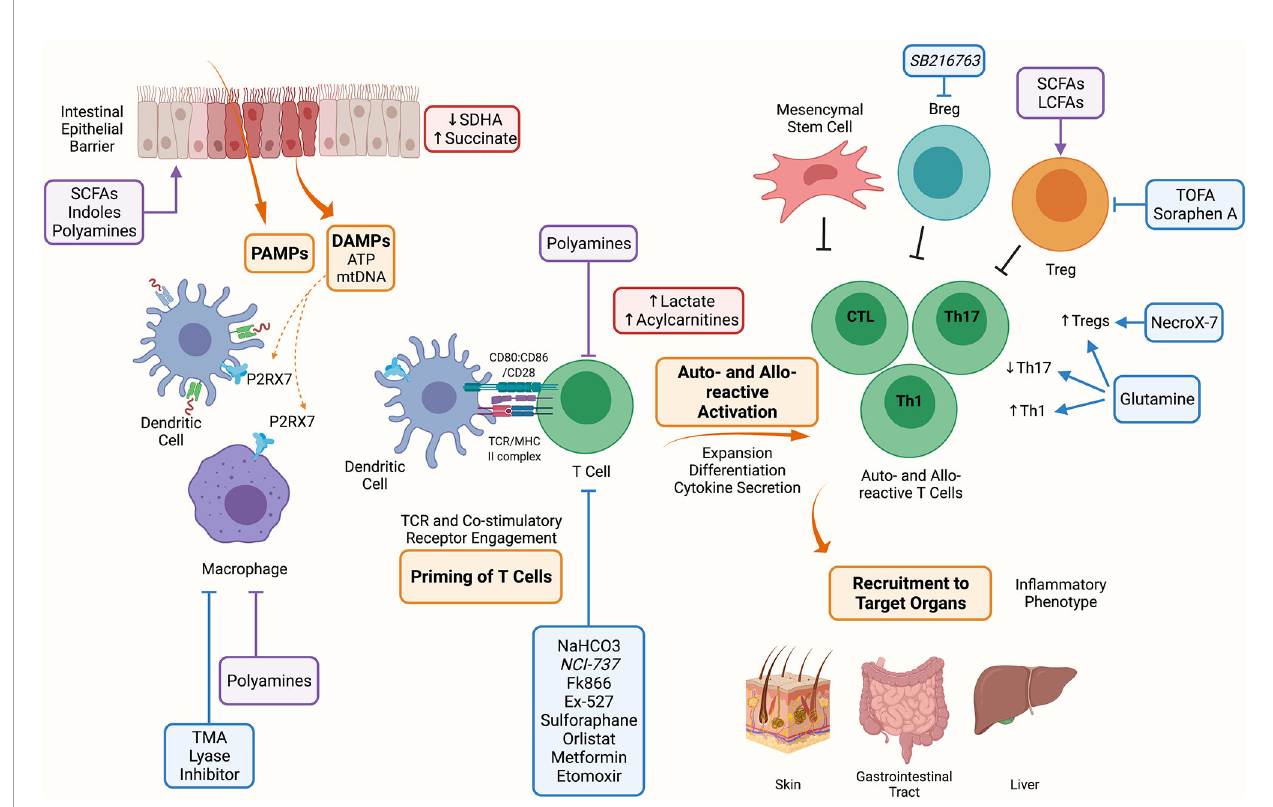
FIGURE 1 | Metabolic Targets of Acute Graft Versus Host Disease. The conditioning regimen mediates tissue damage releasing PAMPs and DAMPs, these prime APCs to activate T cells. Alloreactive T cells expand and differentiate into in fl ammatory Th1, Th17 and CTLs. Alloreactive T cells contribute to the in fl ammatory milieu through secretion of IL-2, IFN- g and TNF-a. These activated alloreactive donor T cells can be recruited to target organs including the skin, GI tract and liver to mediate the in fl ammatory phenotype characteristic of aGVHD. Indicated in blue are metabolic targets for the treatment of aGVHD. Trimethylamine (TMA) lyase inhibitor prevents the polarization of macrophages into M1 cells. Inhibitors against the nicotinamide phosphoribosyl transferase pathway (Fk866), lactate dehydrogenase (NCI-737), sirtuin-1 (Ex-527), lysosomal lipase (orlistat), fatty acid oxidation (etomoxir); along with activators of 5 ’ -AMP-activated protein kinase (AMPK) (metformin) and nuclear factor 2 (sulforaphane) may or have been shown to target allo-reactive T cell function in aGVHD. NaHCO 3 has been shown to abrogate lactate accumulation in allo-reactive T cells. Inhibitors of fatty acid synthesis (FAS) (5-(Tetradecyloxy)-2-furoic acid (TOFA), Soraphen A), reactive oxygen species (NecroX-7), and glutamine administration improve the suppressive function and increase Tregs aiding to alleviate aGVHD. Lastly, GSK3 b inhibitor (SB216763) has been shown to enhance regulatory B cells (Bregs) differentiation and suppressive function and may be a therapeutic target in aGVHD. Indicated in red are metabolites that have been shown to accumulate during aGVHD, these include succinate in IECs due to reduced SDHA activity, and lactate and acylcarnitines in allo-reactive T cells. Indicated in purple are microbial metabolites that act on cells during aGVHD, these include short chain fatty acids (SCFAs), long chain fatty acids (LCFAs), indoles and polyamines which can act on immune (macrophages, T cells, Tregs) and non-immune (IECs) cells. Created with